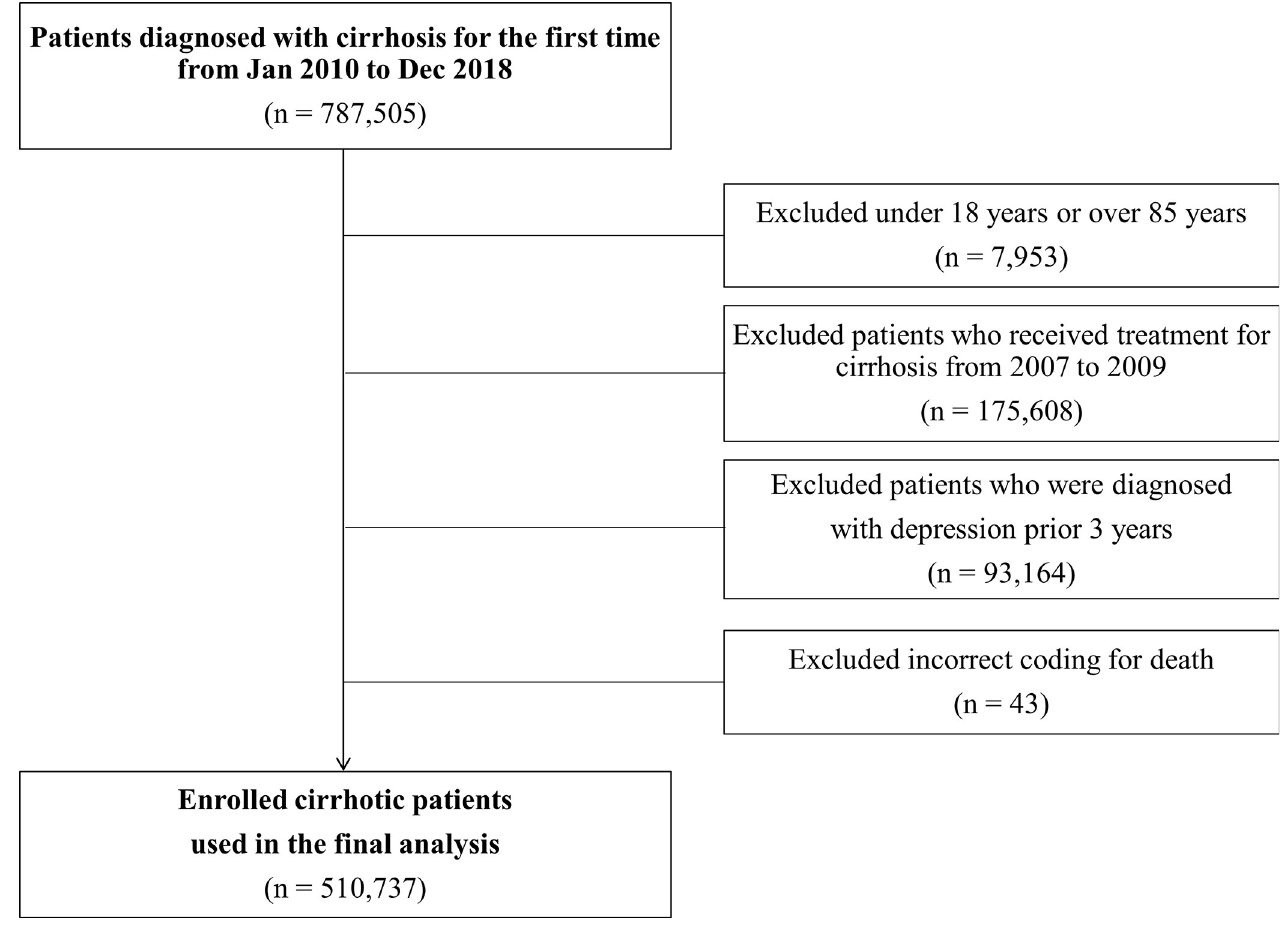
to -91 days, and -90 days to -31 days was 4.04, 4.41, and 5,56, respectively. The IR after diagno- sis of cirrhosis was the highest at +30 days to +89 days at 7.54 persons per 100 person-year, and then at +90 days to +179 days, +180 days to +359 days, and +360 days to +719 days, with 5.82, 4.99, and 4.36, respectively. Although IR decreased slightly compared to immediately after diagnosis, it was still higher than the baseline (Table 1, Fig 2A). The IRR of developing depression mildly increased before diagnosis of cirrhosis (-360 to -181, IRR 1.14, p < 0.001; -180 to -90, IRR 1.24, p < 0.001; -90 to -31, IRR 1.56, p < 0.001) and rapidly increased immediately after diagnosis of cirrhosis (+30 to +89, IRR 2.12, 95% confi- dence Interval: 2.06–2.18, p < 0.001). After that, the rate of increase in IRR decreased over time (+90 to +179, IRR 1.64; +180 to +359, IRR 1.40, p < 0.001; +360 to +719, IRR 1.22, p < 0.001), compared to the rate of increase during the period of reference (from day -720 to -361) (Fig 2A). Our study further conducted stratified analysis according to sex and age. The pattern of increasing depression immediately after the diagnosis of cirrhosis was observed equally in all sexes and ages. The IR of depression within three months after diagnosis of cirrhosis was 5.05, 6.69, 4.48, 6.55 per 100 person-year in men, women, young patients and elderly patients, respectively, with the IRR of 1.62, 1.48, 1.55, and 1.58, respec- tively (Fig 2B and 2C).